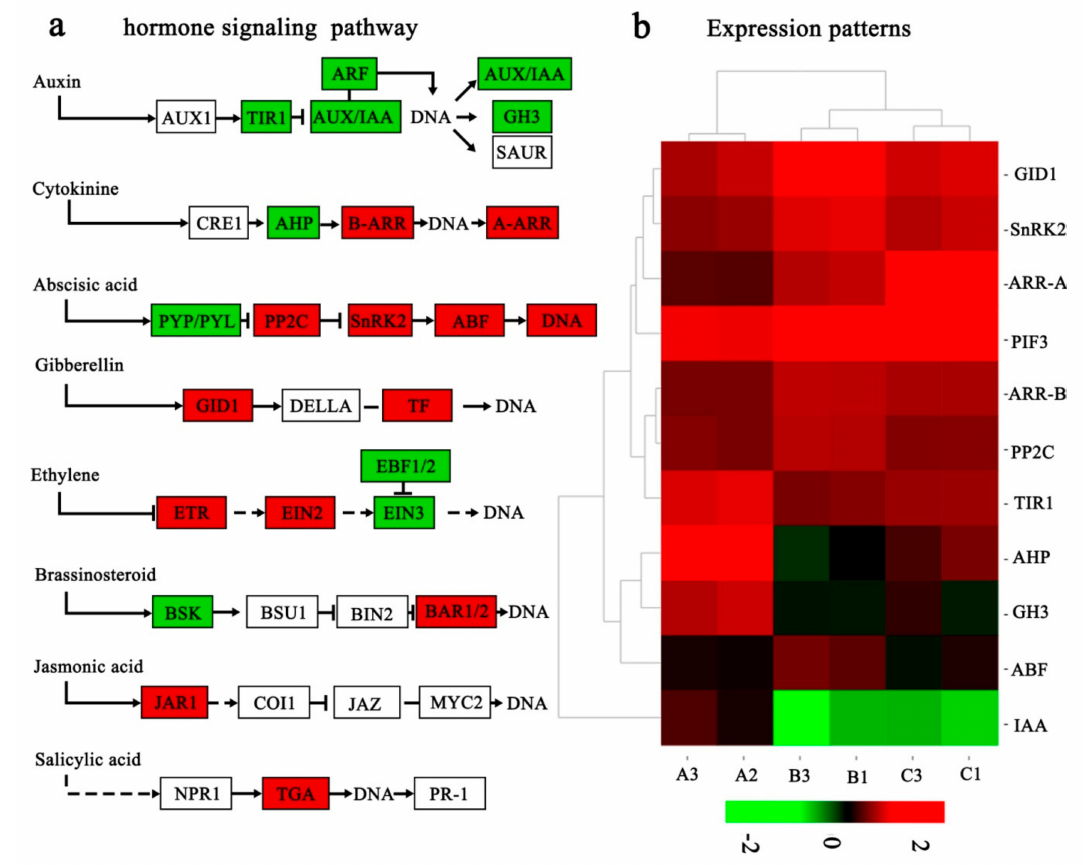
Figure 5. The di ff erentially expressed genes in the hormone signaling pathways in response to low temperature in Camellia oleifera ‘Huaxin’. ( a ) The green and red boxes show the mapped di ff erentially expressed genes in the plant hormone signaling pathways, as modified from a Kyoto Encyclopedia of Genes and Genomes map (KO 04075), and the green boxes indicate down-regulated genes, whereas red boxes indicate up-regulated genes. ( b ) The expression patterns are shown as a heat map. Changes in expression level are indicated by a change in color, green indicates a lower expression level, whereas red indicates a higher expression